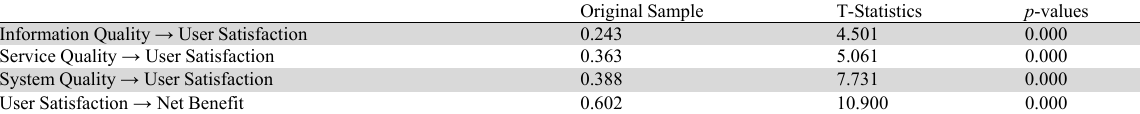
Results of Path Coefficients